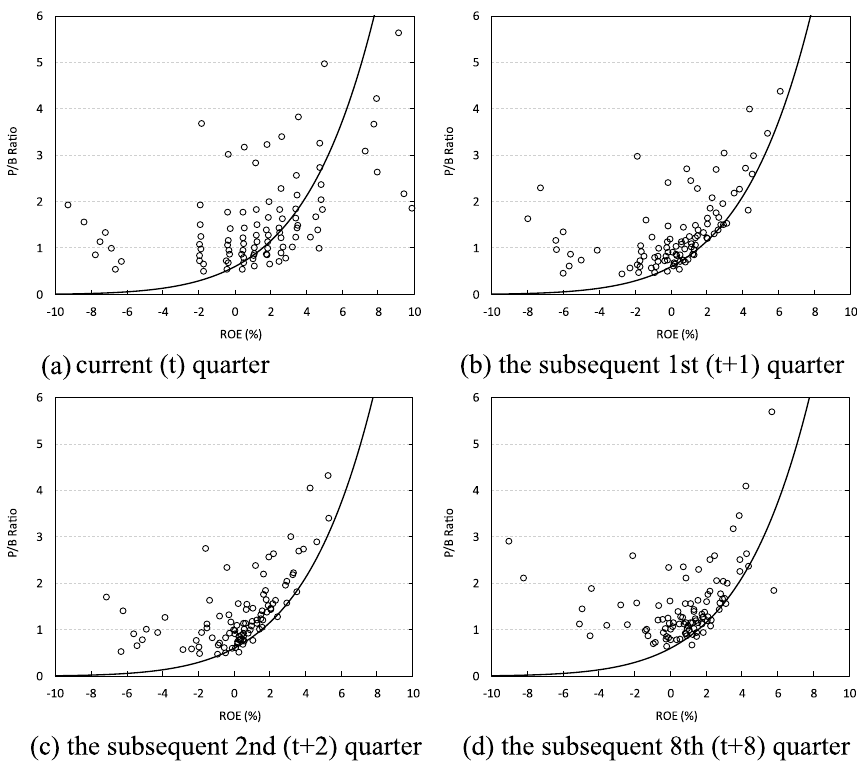
Fig. 18 ROE (X axis) and P/B (Y axis) in the current quarter and the subsequent 1st, 2nd, and 8th quarter after the portfolios are formed: Small momentum stocks